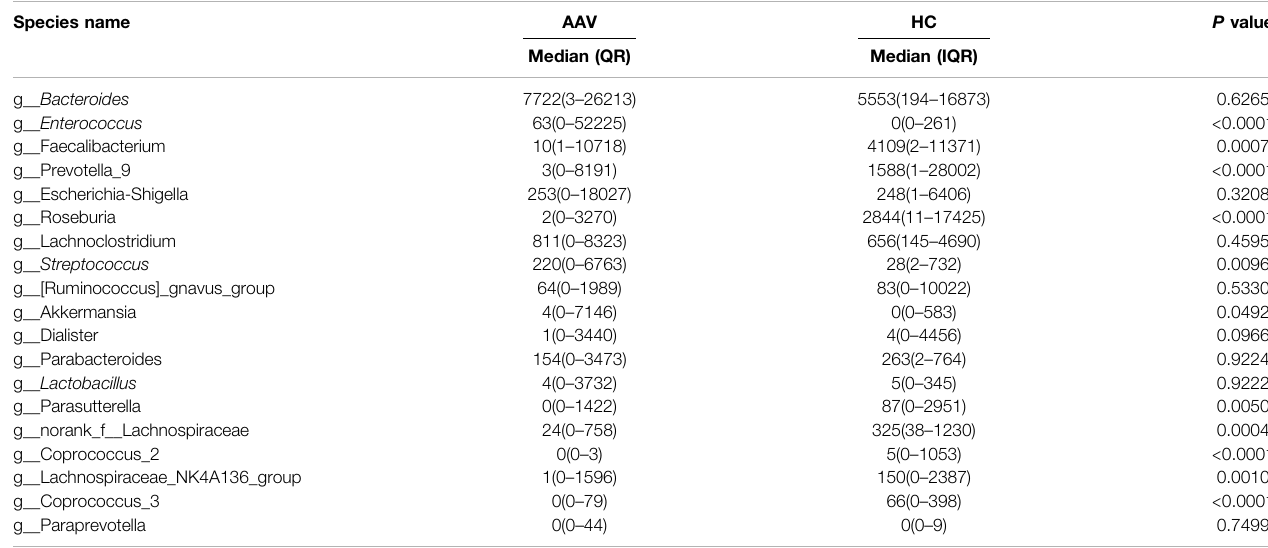
TABLE 2 | Gut microbiota composition between AAV and HC at the genus